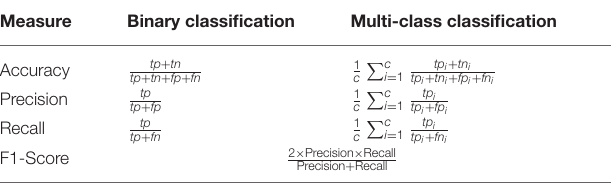
TABLE 2 | Classification performance